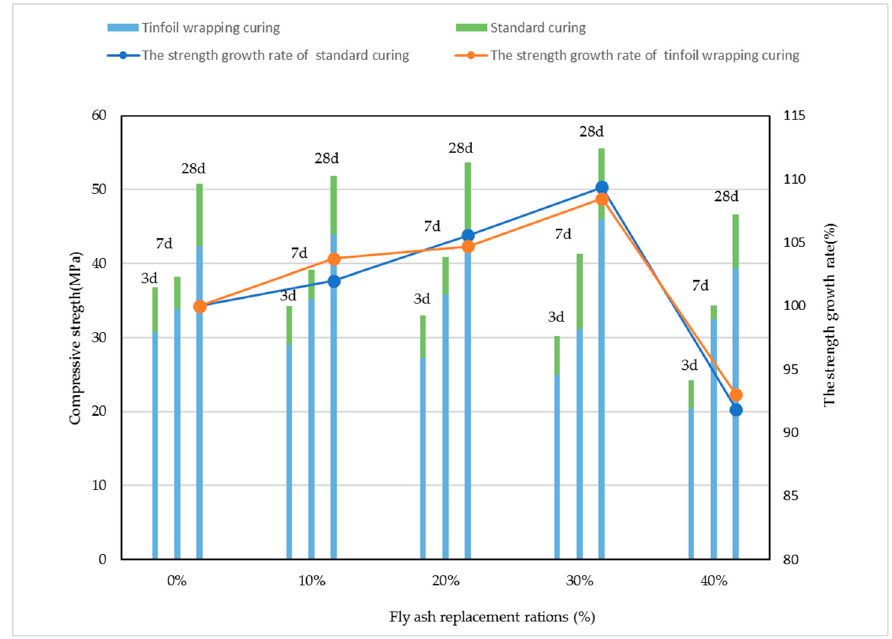
Figure 7. The Compressive Strength of SCC.